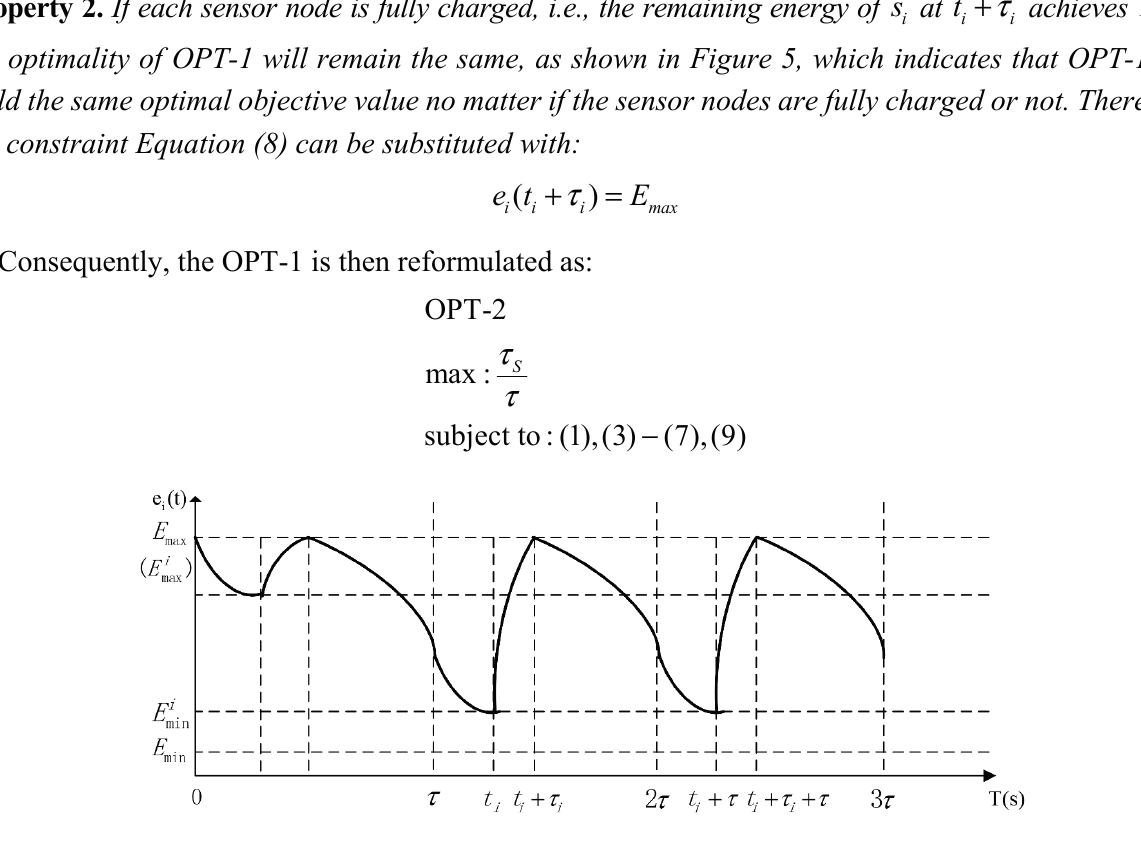
Figure 5. The energy-time curve of a fully charged sensor